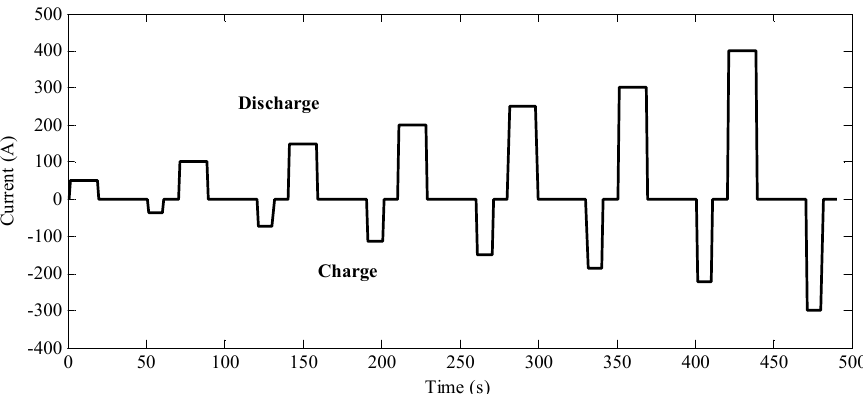
Figure 8. Profile of self-defined HPPC for one